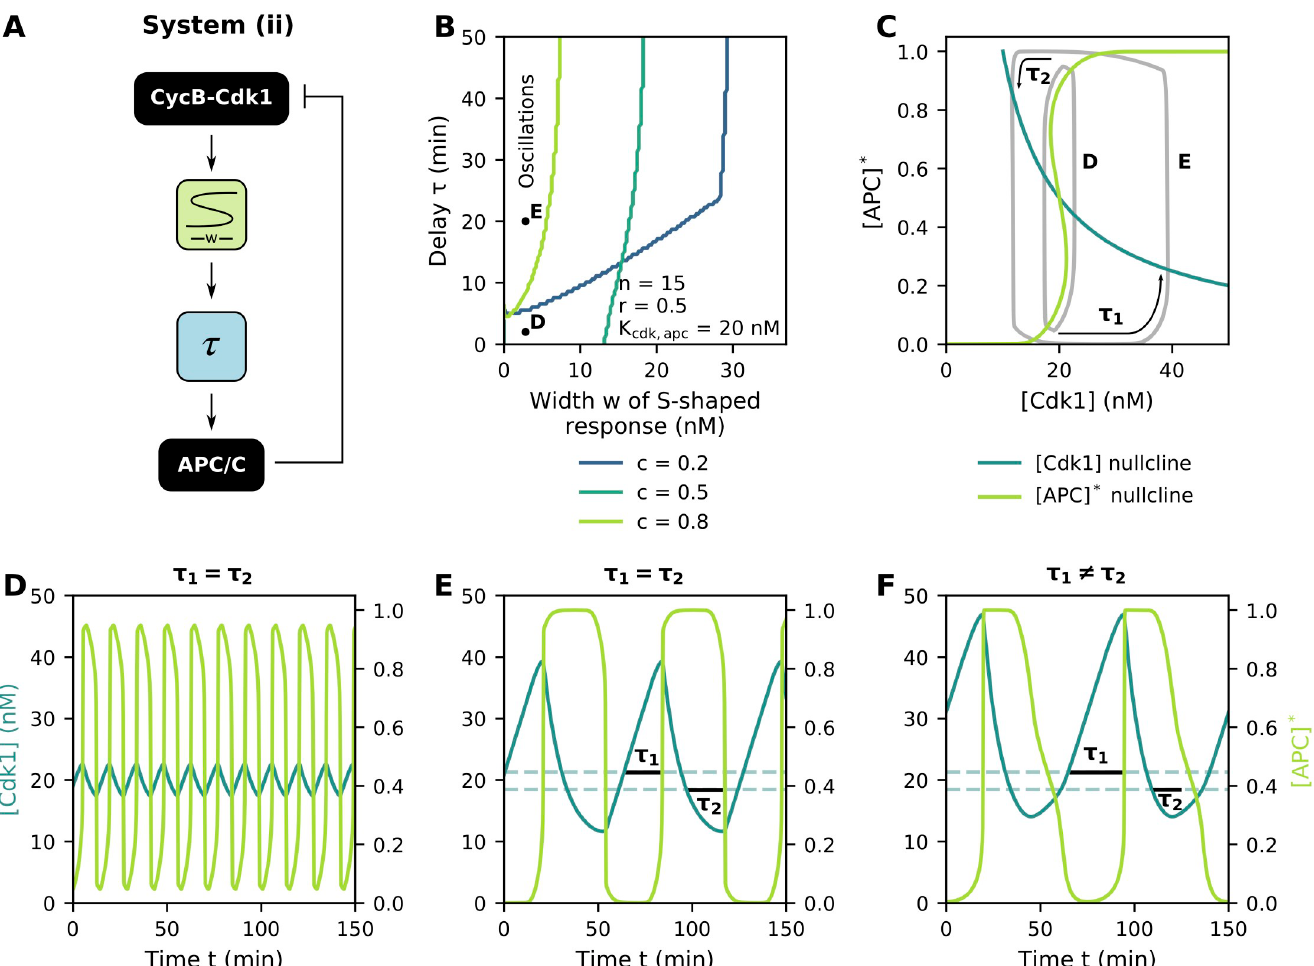
Fig 5. Delay increases the period, amplitude and robustness of oscillations. Parameter values as indicated in the figure/caption. (A) Block diagram of the bistable, delayed negative feedback network. (B) Oscillatory regions, located above and to the left of the plotted lines, as a function of the time delay and width of the S-shaped response for different values of the relative synthesis rate c . (C) Phase plane representation of the oscillations for different values of τ . Note how one can only conclude that τ 1 = τ 2 from time traces, not directly from the phase plane. (D,E) Time traces for parameter values indicated in panel B and c = 0.5. τ 1 denotes the delay between activation of [Cdk1] and activation of [APC] � , while τ 2 represents the delay between their inactivations. Dashed lines depict the [Cdk1] levels at the folds of the bistable [APC] � nullcline. (F) State-dependent time delays can account for differences in the activation and inactivation delays ( c = 0.5, p = 5).